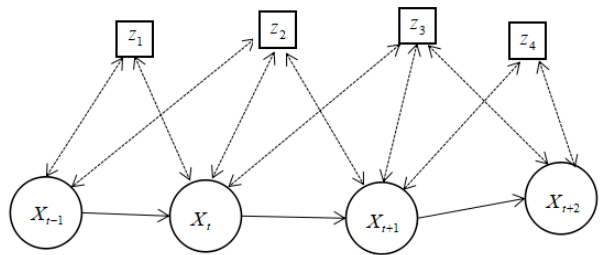
Figure 2. Sketch map of graph optimization.